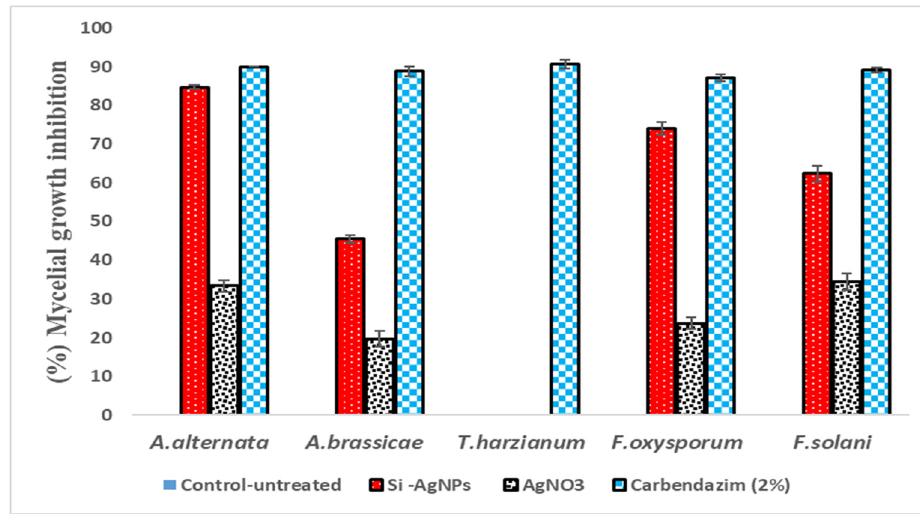
Figure 9: Percentage mycelial growth inhibition of fungal isolates treated with Si - AgNPs at 80 µg · mL − 1 .